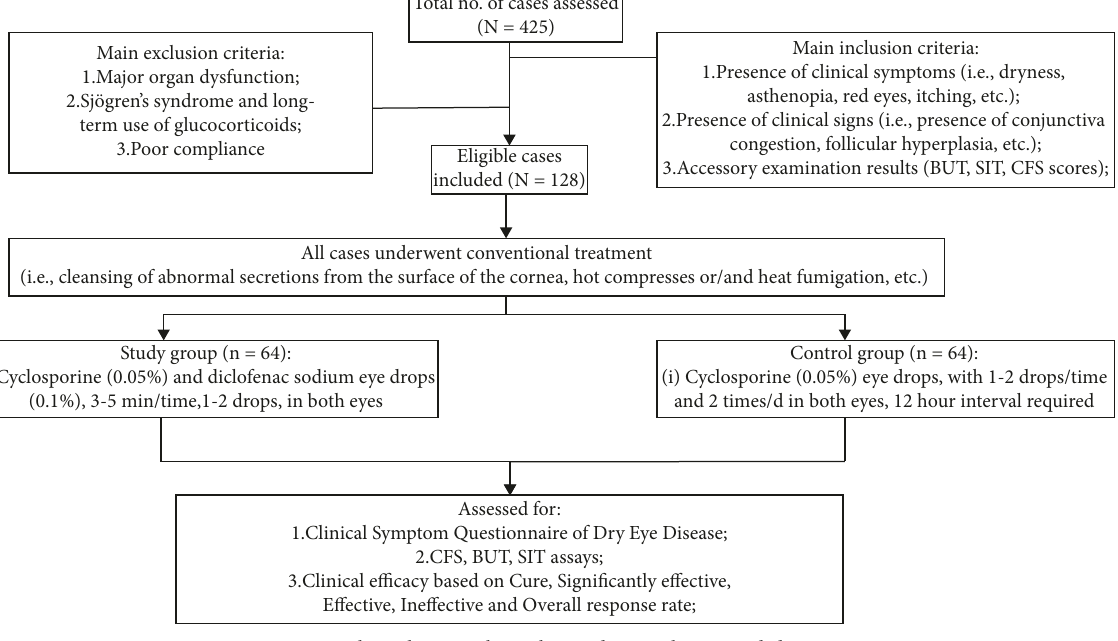
Figure 1: Flow chart to show the study population and design. Table 1: Comparison of clinical symptoms, CFS, BUT, and SIT scores between the two